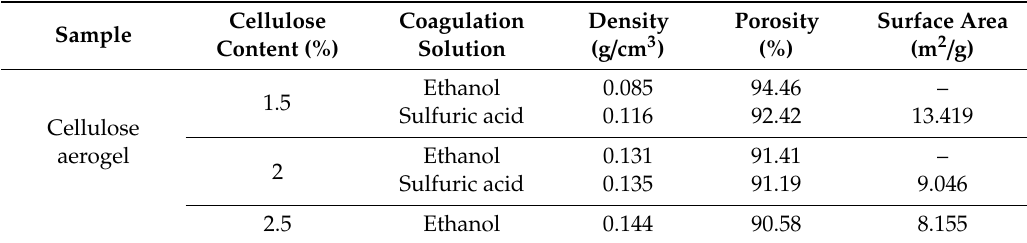
Table 1. Physical properties of cellulose aerogels.